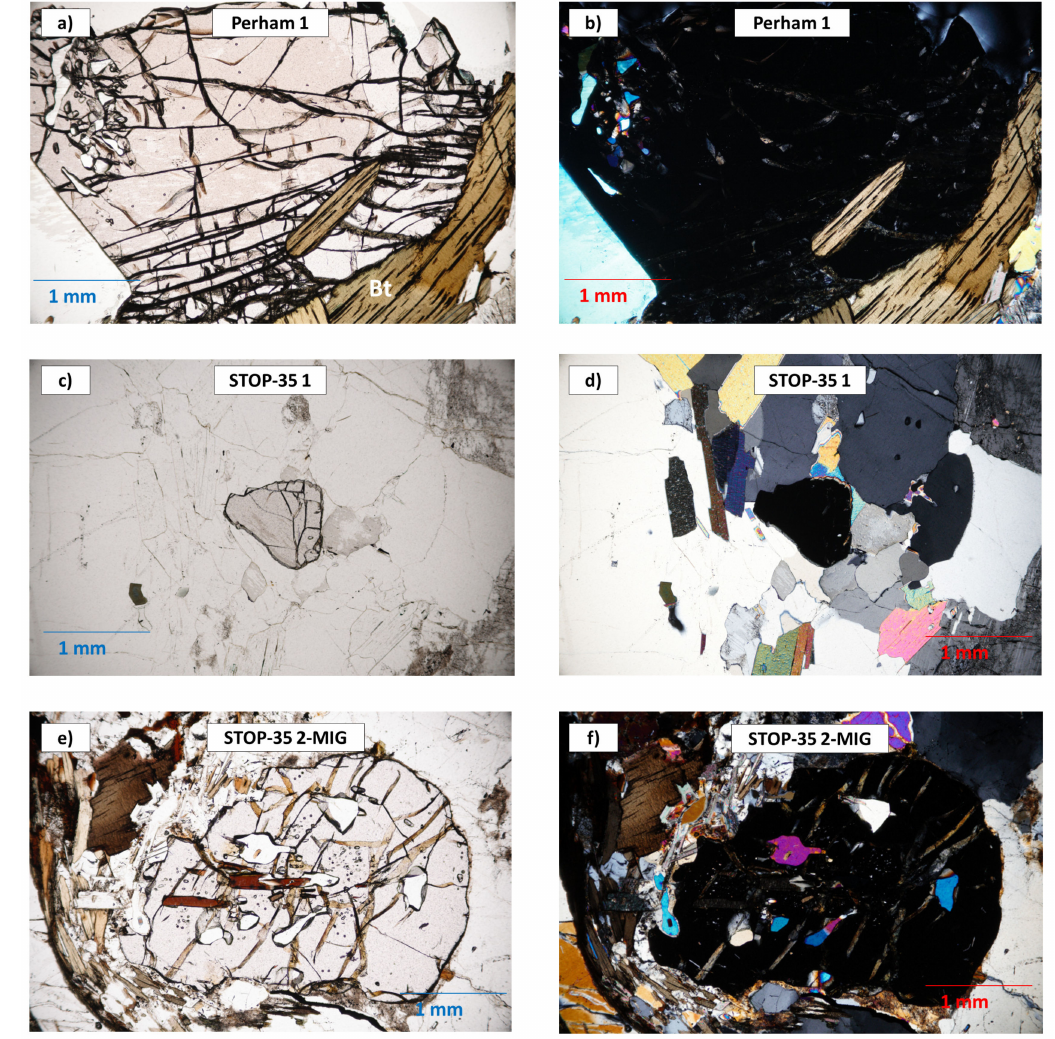
Figure 8. Photomicrographs of garnet from the barren pegmatites and the hosting migmatite. Left: plane-polarized light; right: crossed-polarized light. ( a , b ) Garnet from the Perham pegmatite with biotite and quartz inclusions. ( c , d ) Garnet from the Stop-35-pegmatite in a plagioclase, quartz and muscovite matrix. ( e , f ) Garnet from the Stop-35-migmatite with abundant quartz and micas